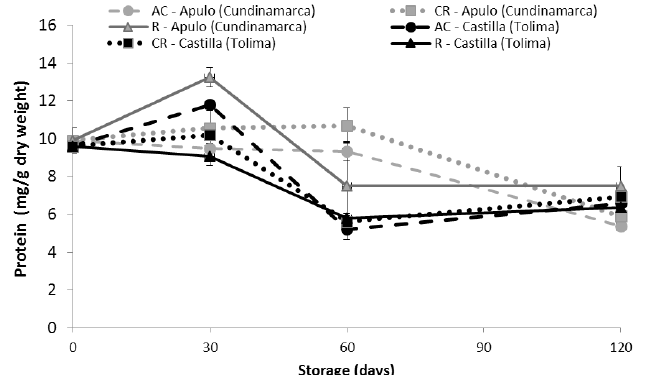
Fig. 2: Soluble protein content of A. squamosa L. seeds from Castilla-To- lima (black lines) and Apulo-Cundinamarca (gray lines) for the four periods of storage under ambient conditions, AC (dashed lines), cool room CR (continuous points) and refrigeration R (solid lines). Ger- mination incubation was at 35 °C and 60% RH in wet peat. Vertical bars indicate standard error (±), n =